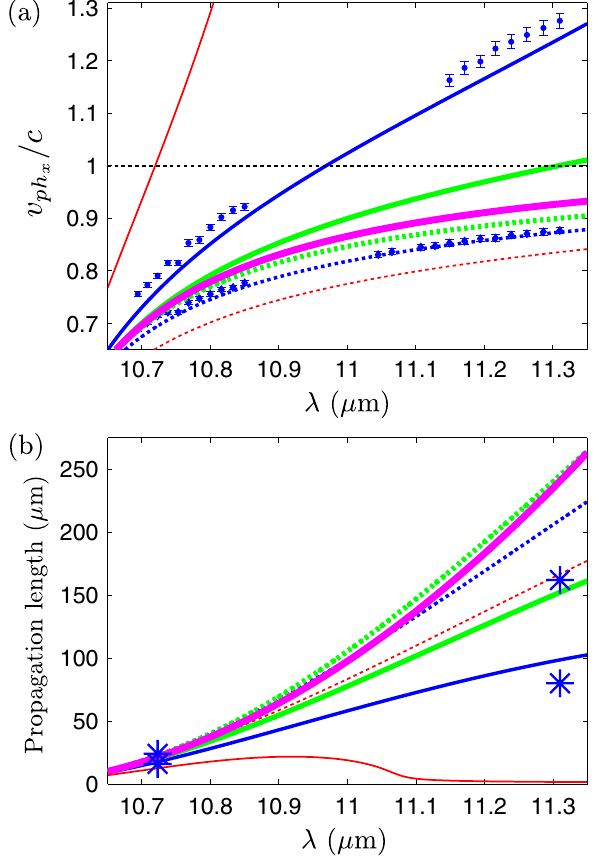
FIG. 3. (a) Theoretical (lines) and experimental (symbols) phase velocities plotted for different values of vacuum gap widths 2 a . Experimental data were derived from R ð (cid:6) and correspond to 2 a ¼ 6 (cid:2) m . (b) Theoretical plots of L prop ¼ 1 = 2 k 00 , with experimental estimates of propagation lengths for two frequencies, are included. Color scheme (and linewidths from thin to thick): 2 a ¼ 4 (cid:2) m (red), 6 (cid:2) m (blue), 9 (cid:2) m (green), and 1 (single interface, magenta). Solid lines: accel- erating L-modes, dashed lines: deflecting